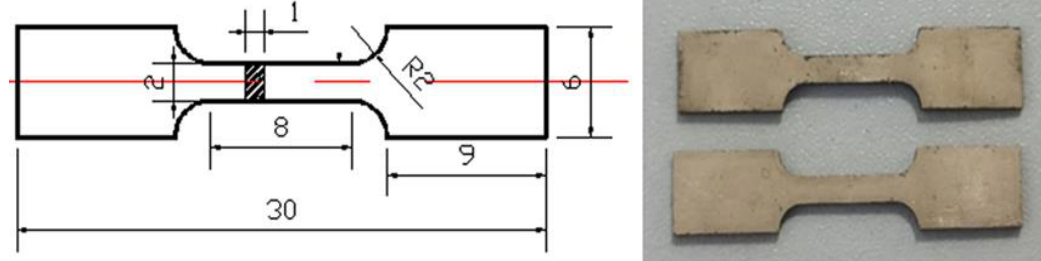
Figure 2. A schematic diagram of tensile specimens, with dimensions; tensile samples.